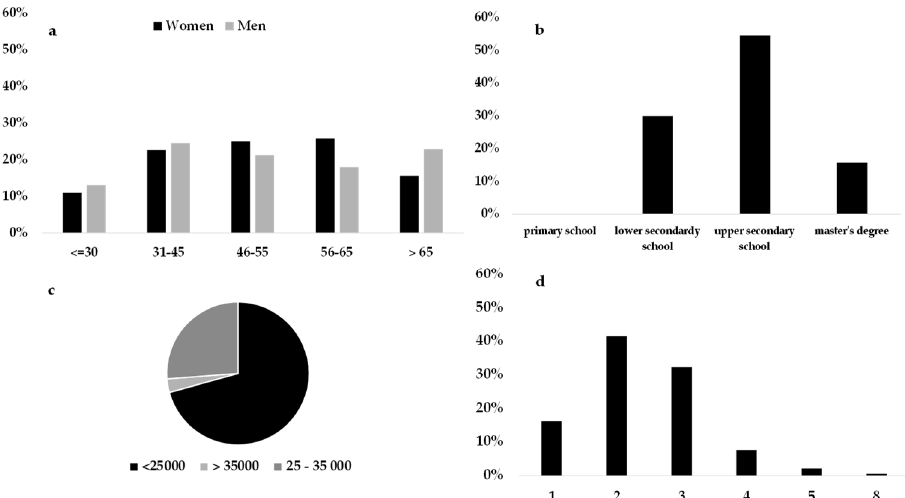
Figure 3. Sociodemographic characteristics of consumers belonging to price sensitive cluster: ( a ) Gender and age groups proportion, ( b ) educational level, ( c ) yearly average income bracket, and ( d ) number of family components.